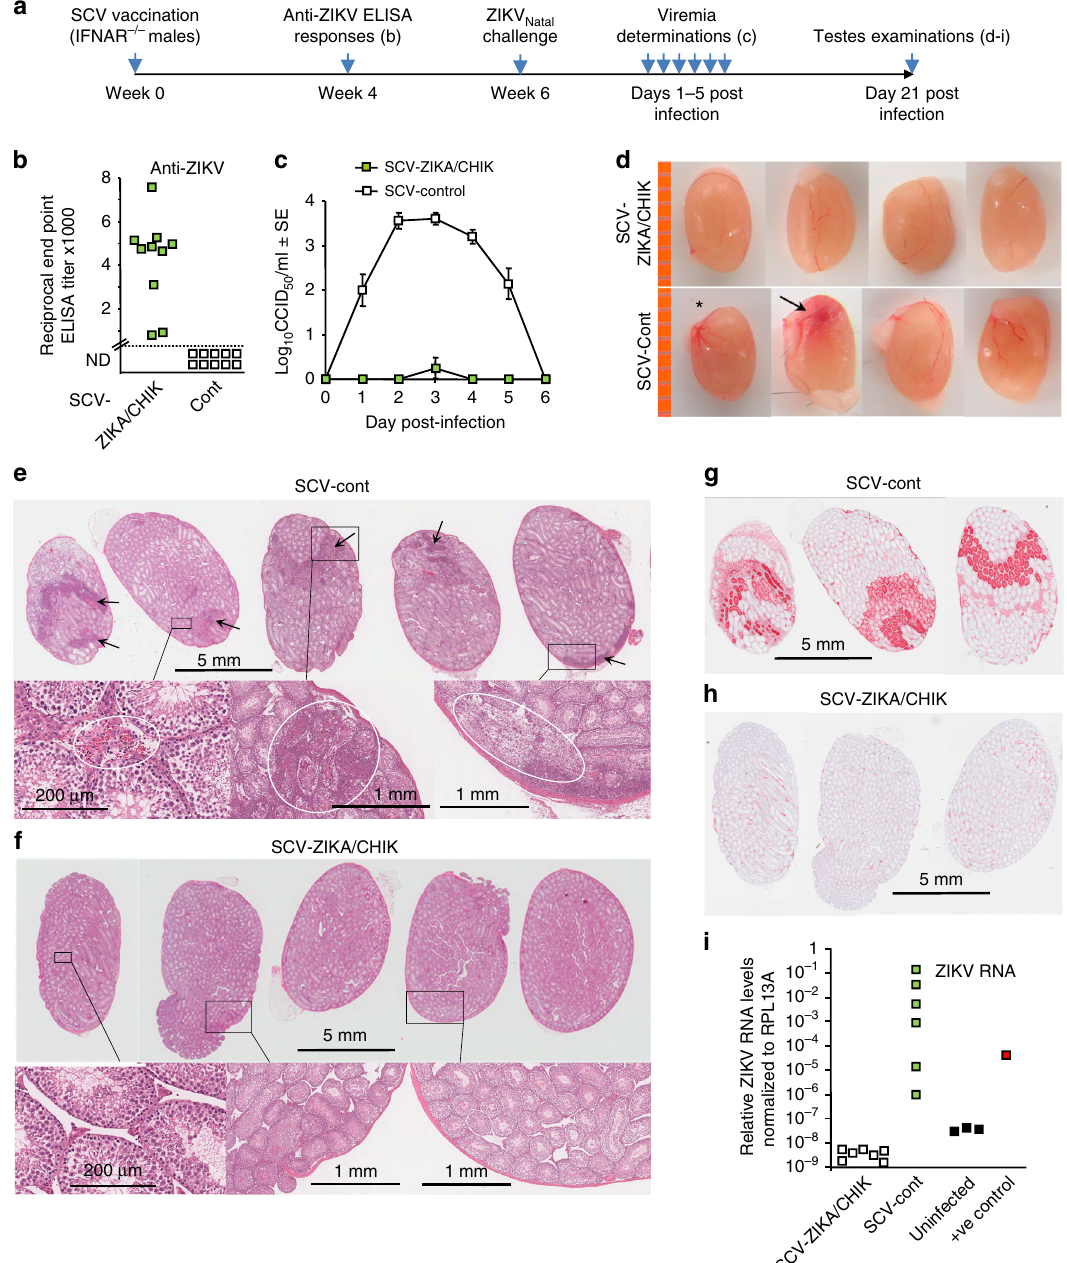
Fig. 5 Challenge of vaccinated male IFNAR − / − mice with ZIKV Natal . a Timeline of SCV vaccination, challenge, viremia and testes examinations. b Anti-ZIKV serum IgG ELISA titers 4 weeks after vaccination with SCV-ZIKA/CHIK or SCV-cont ( p < 0.001, Kolmogorov – Smirnov test). c Viremia in SCV-vaccinated mice after challenge with ZIKV Natal ( n = 10 mice per group) (days 2 – 4 all p < 0.001, Kolmogorov – Smirnov tests). Error bars represent standard error of the mean. d Pictures of testes taken day 21 after challenge. *One testes (out of 12) was slightly smaller, another showed signs of hemorrhage (arrow). The orange line on the left represents a ruler with 1 mm marks. e H&E staining of testes from SCV-cont vaccinated mice showing dark patches of cellular in fi ltrates (arrows); top row bar = 5 mm. Enlargements of selected areas show (in white circles, left to right) hemorrhage around Leydig cells (in the same testes arrowed in d ), high density of in fl ammatory in fi ltrates in and around the seminiferous tubules, and destruction of seminiferous tubules; bottom row, bar = 200 μ m (left) and bars = 1 mm (2 right hand images). f H&E staining of testes from SCV-ZIKA/CHIK vaccinated mice. Enlargements of selected areas show normal testis architecture with no discernible lesions. Bars as in e . g Immunohistochemistry with 4G4 (anti-NS1 monoclonal antibody) of serial sections of the three testes shown top left in e . Bar = 5 mm. h Immunohistochemistry with 4G4 of serial sections of the three testes shown top left in f . Bar = 5 mm. i ZIKV RNA qRT PCR of testes day 21 post infection. SCV-ZIKA/CHIK vs SCV-cont, p = 0.003 (Kolmogorov – Smirnov test); ( n = 6/7 testes from 6/7 mice per SCV vaccine group). Three uninfected negative control testes from three mice and one known positive control sample were